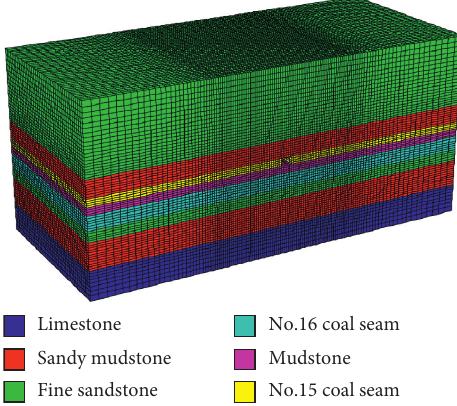
Figure 7: Numerical calculation model.